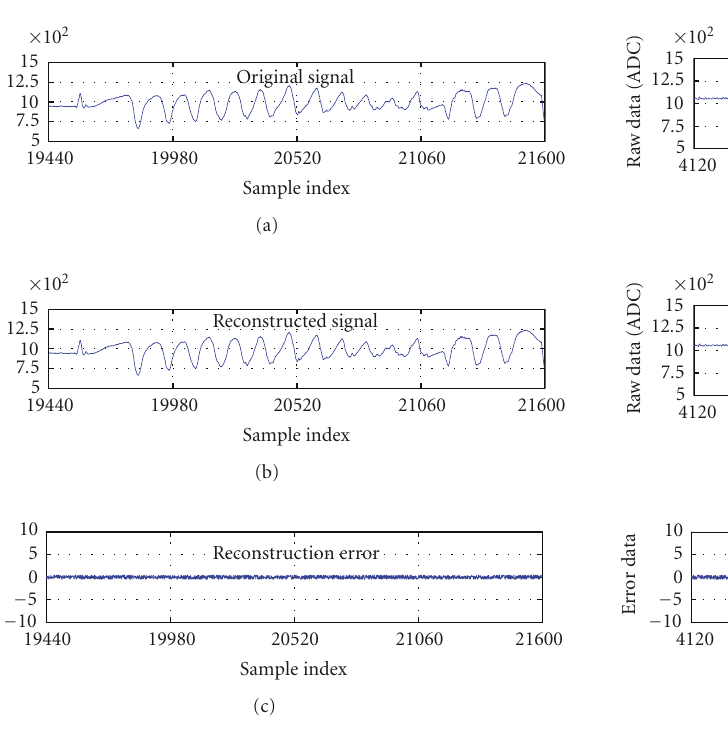
Figure 15: SBT method: original ECG signal along with the re- constructed and residue signals of MIT-BIH ADB record 232V1. In the reconstructed signal, PRD = 0 . 0281, NPRD = 0 . 8863, SNR = 163 . 5516, RMS = 0 . 2901, CR = 3 . 4264 (PH), BPS = 3 . 5023 (PH), and CDR = 105 . 0681